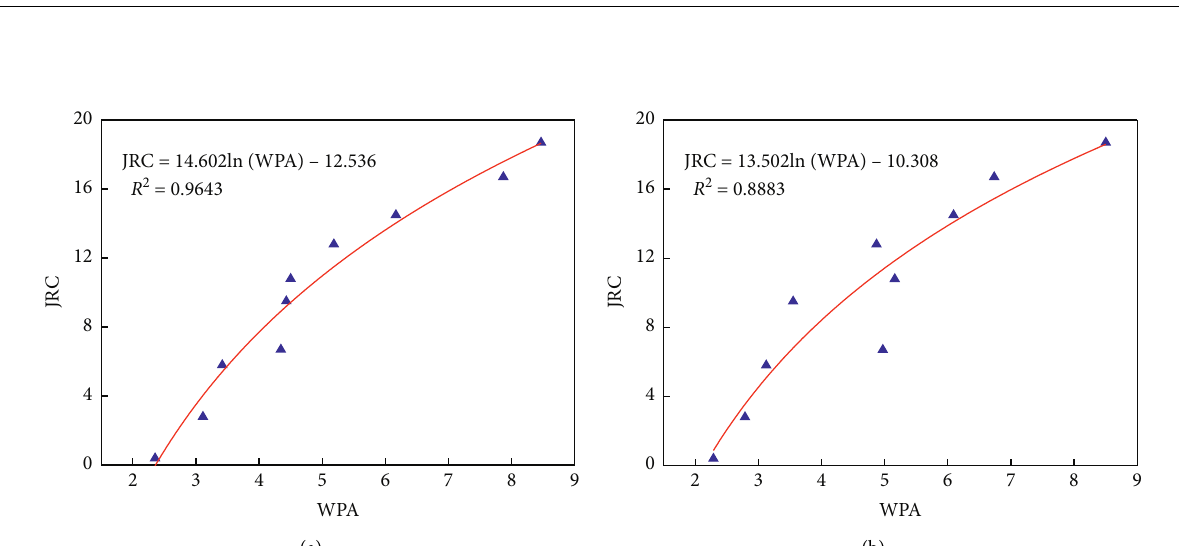
Figure 7: The functional relationships between WPA and JRC in two shear directions. (a) Direction 1. (b) Direction